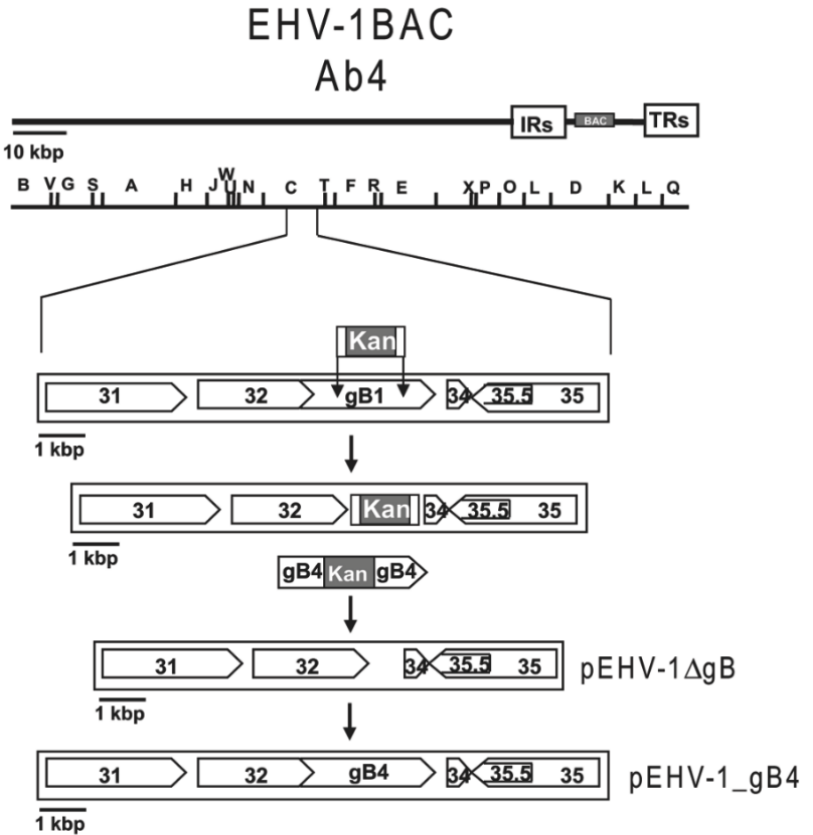
Figure 2. Schematic diagram of the procedures used to construct mutant genomes (EHV-1_gB4 as model). The two unique regions (UL and US) of the EHV-1 genome as well as the terminal and internal repeat sequences (TRS and IRS) are shown, as is the inserted mini-F cassette. PCR products of the kanamycin resistance gene ( KanR ) were transformed into GS1783 containing the EHV-1 bacterial artificial chromosomes (BACs) by electroporation and the first step of the Red recombination method ensued. In the second step of Red recombination, the KanR gene was excised, thereby obtaining the pEHV-1∆gB deletion construct. The PCR-amplified gB4Kan was then electroporated into GS1783 harboring pEHV-1∆gB, and, again, two-step Red recombination was performed to obtain the final construct